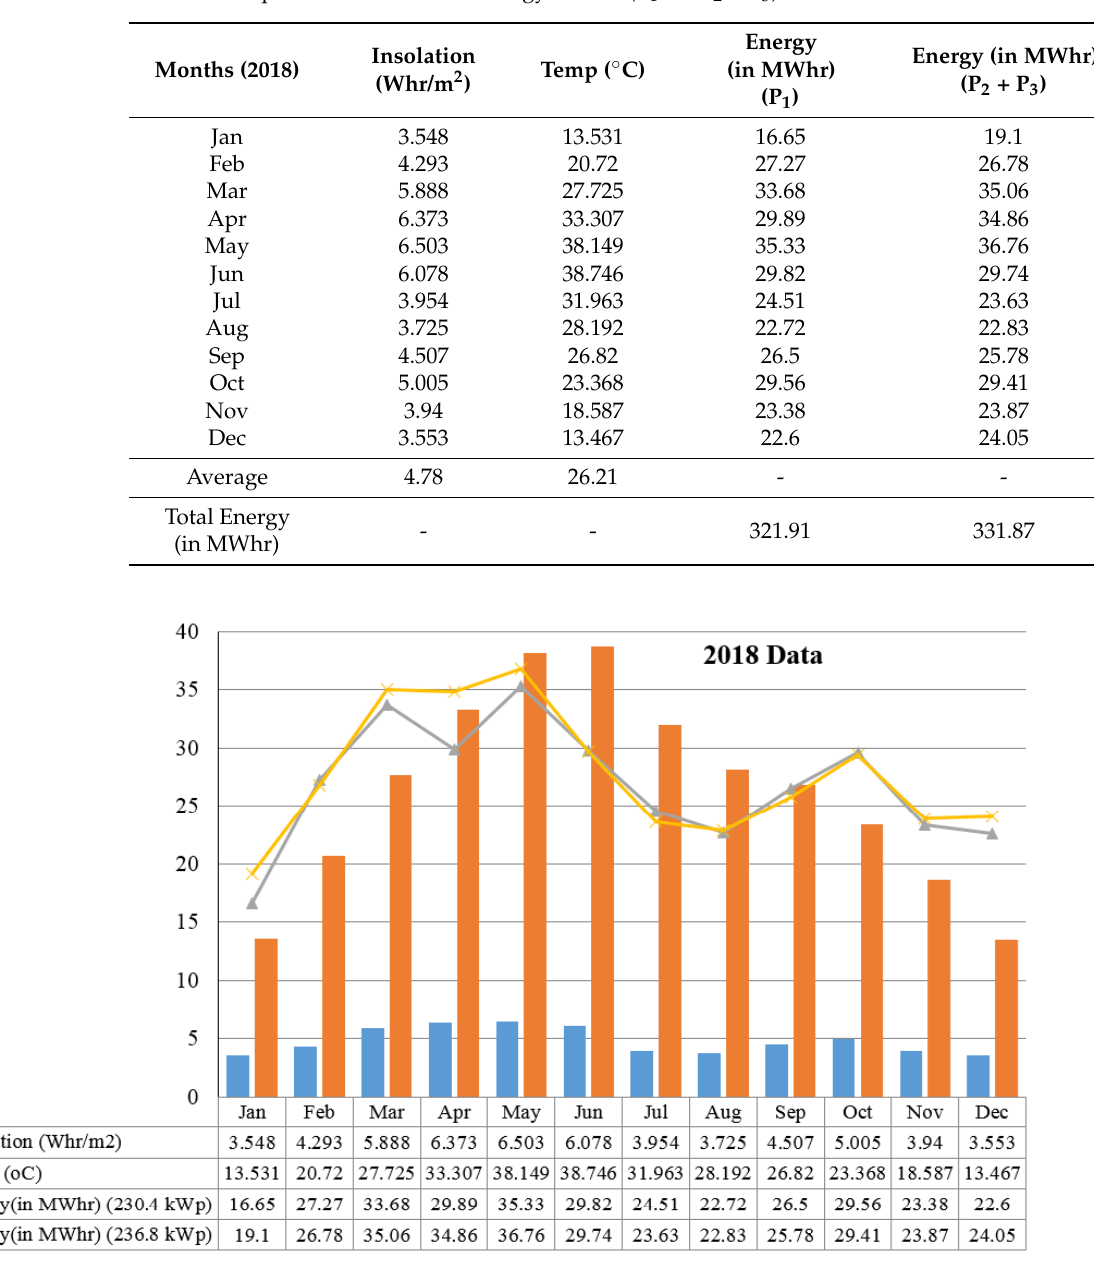
Figure 5. Comparison of Generated Energy in 2018 (P 1 vs. P 2 + P 3 ) .